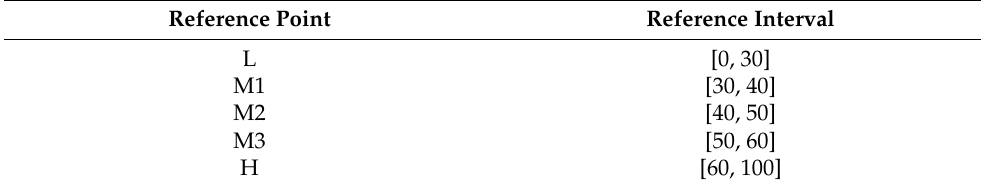
Table 5. Reference point and reference intervals of premise attribute 1.